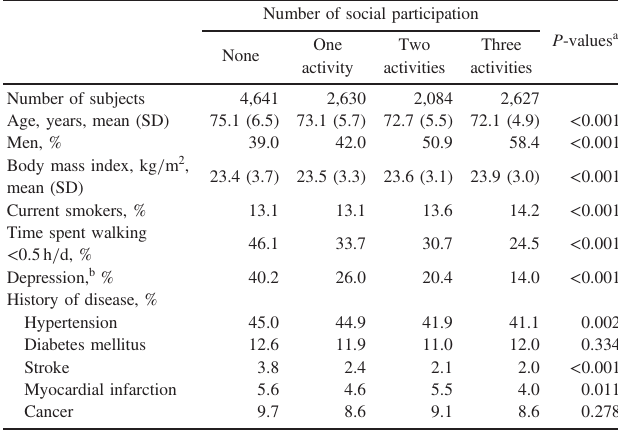
Table 1. Baseline characteristics of the study participants according to the number of social participation ( n =